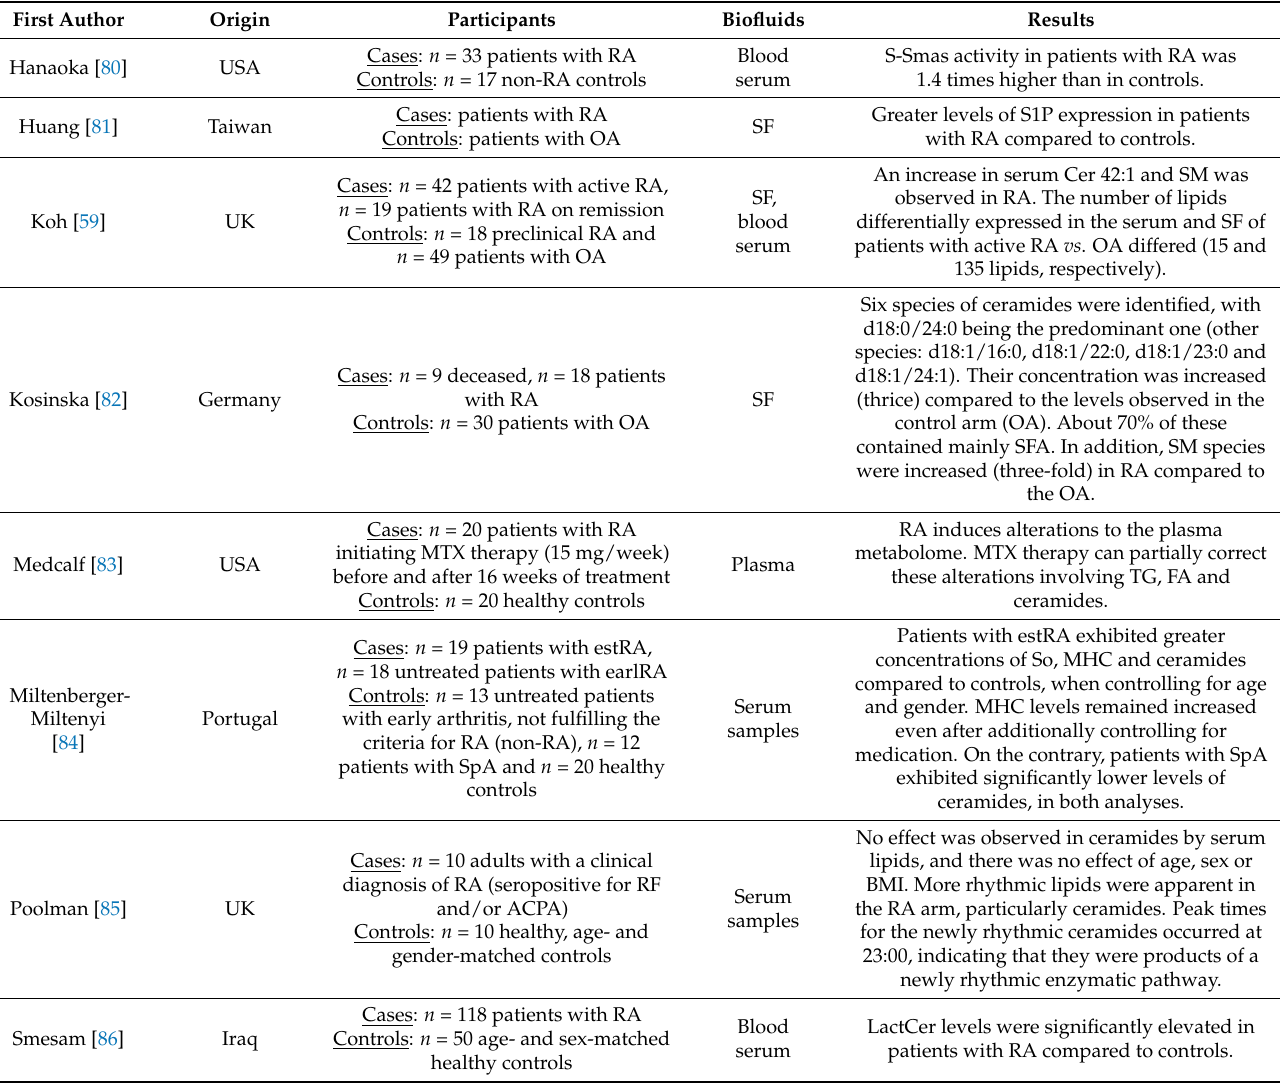
Table 1. Summary of studies assessing ceramide levels in patients with rheumatoid arthritis